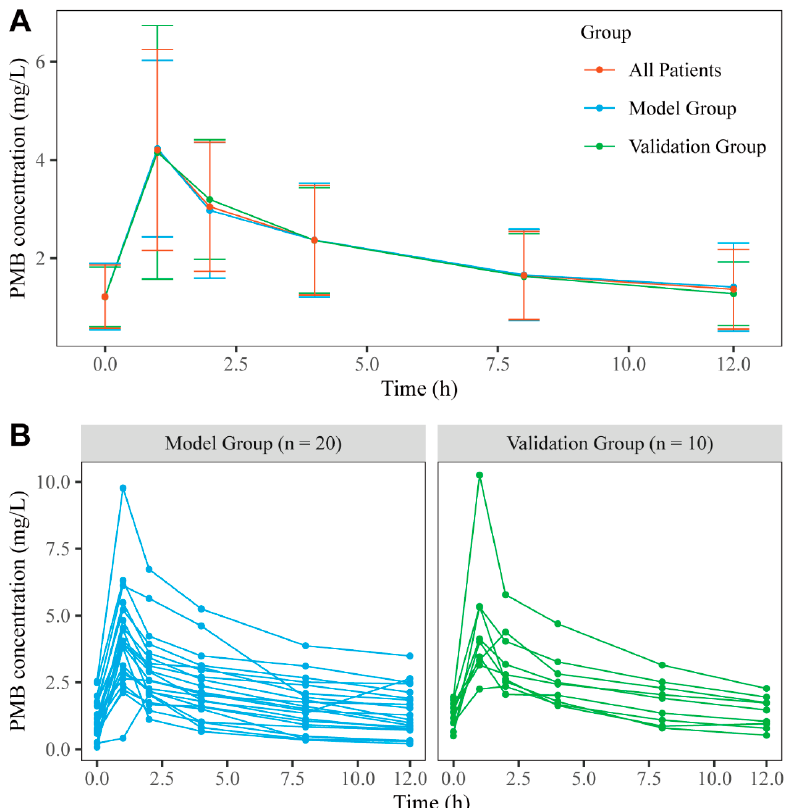
Figure 1. The concentration–time profiles of the model group and validation group. ( A ) The PMB concentration (arithmetic mean ± SD) versus time profiles of all patients, model group, and validation group. The red lines represent all patients, and the blue lines and green lines represent the model group and validation group, respectively. ( B ) The concentration–time profiles of the model group (n = 20) and validation group (n = 10). The blue lines and green lines represent the model group and validation group,